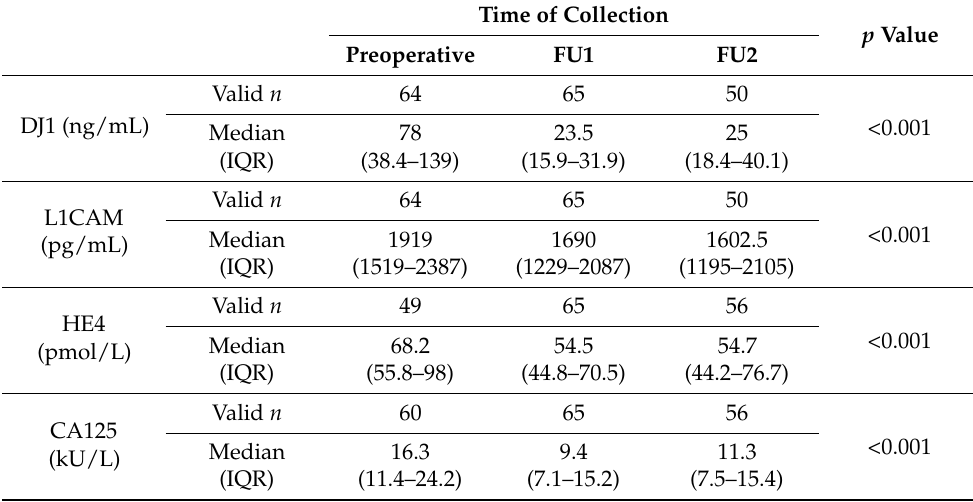
Table 3. The measured DJ1, L1CAM, HE4 and CA125 levels in patients with